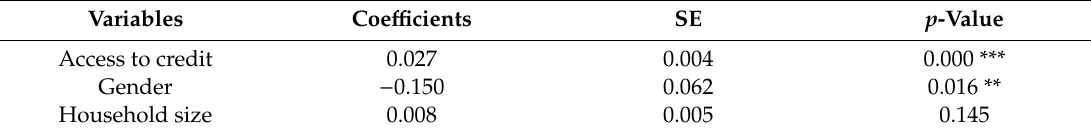
Table 2. Estimates for the dependent variable fertilizer intensification (FI): IV-Tobit.